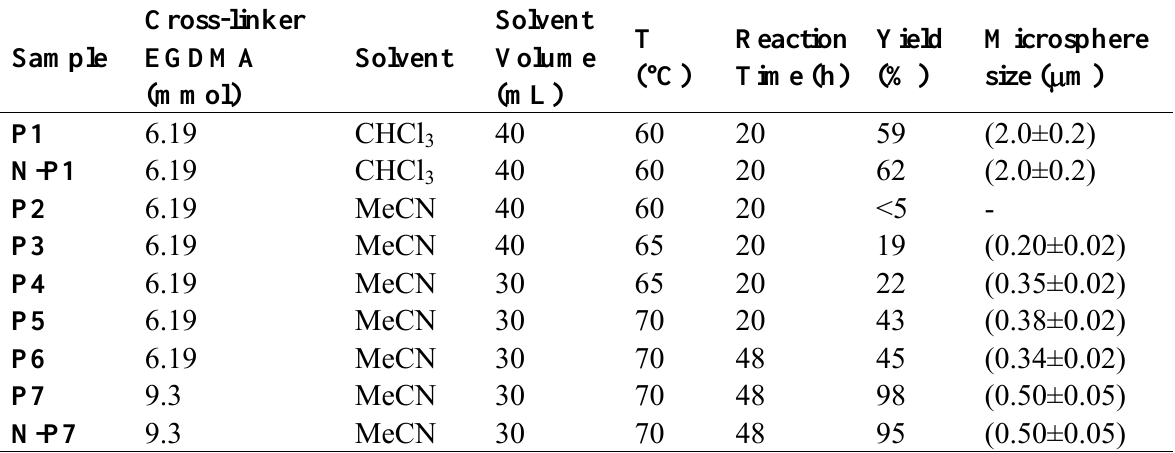
Table1. Experimental conditions of MIP and NIP synthesis a , yields and microsphere